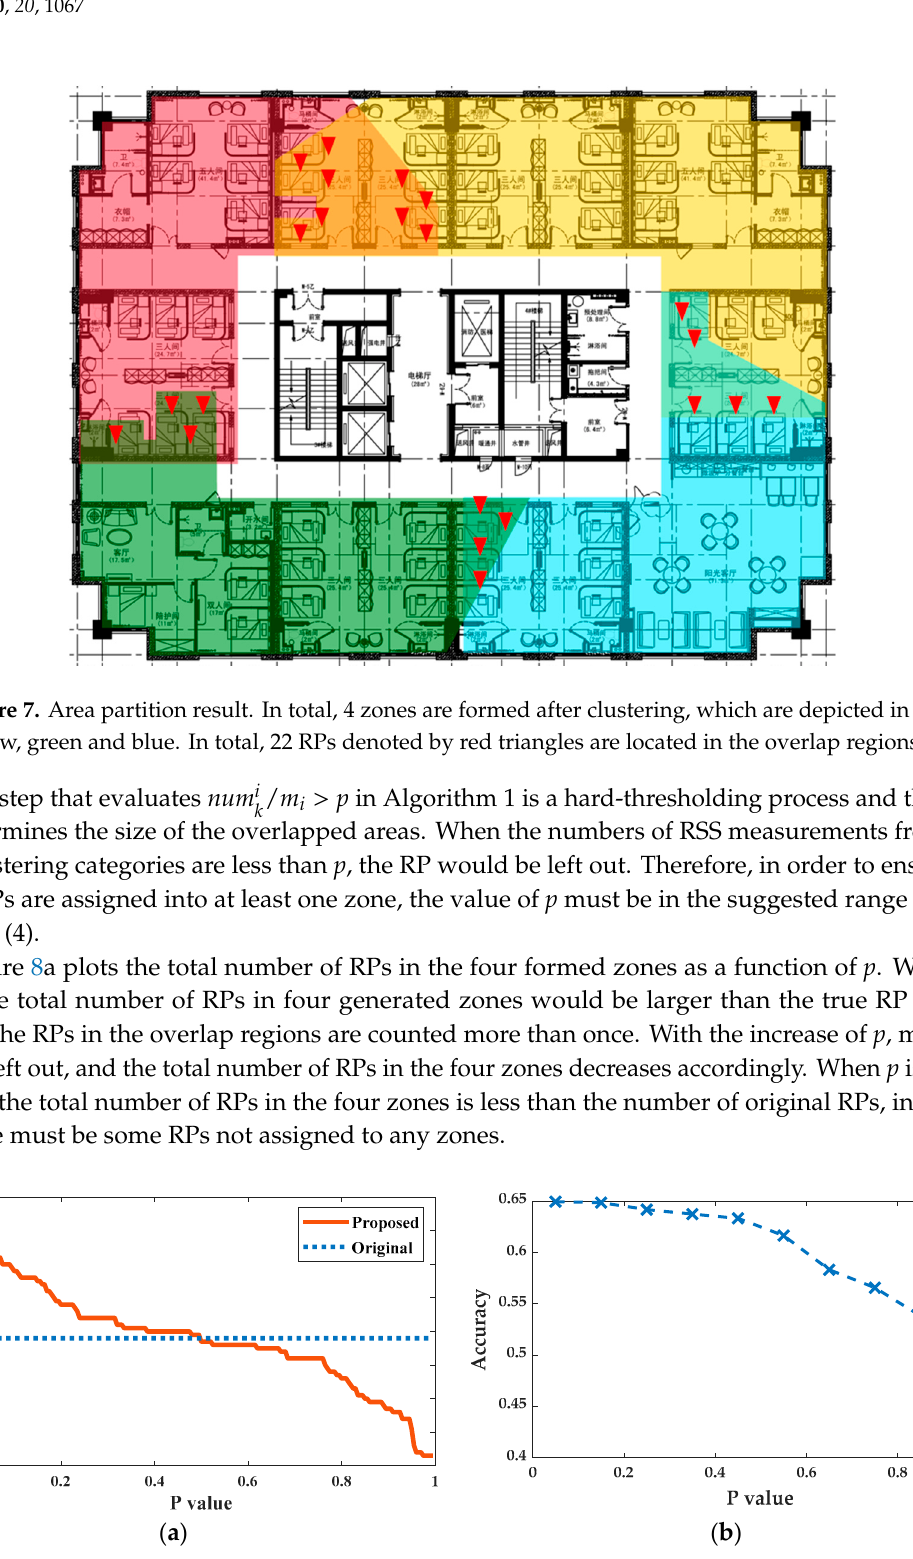
Figure 8. ( a ) Total number of RPs counted in the 4 zones generated using the proposed improved K-Means clustering algorithm. The dotted blue line shows the true RP number for comparison. ( b ) Position classification accuracy as a function of p